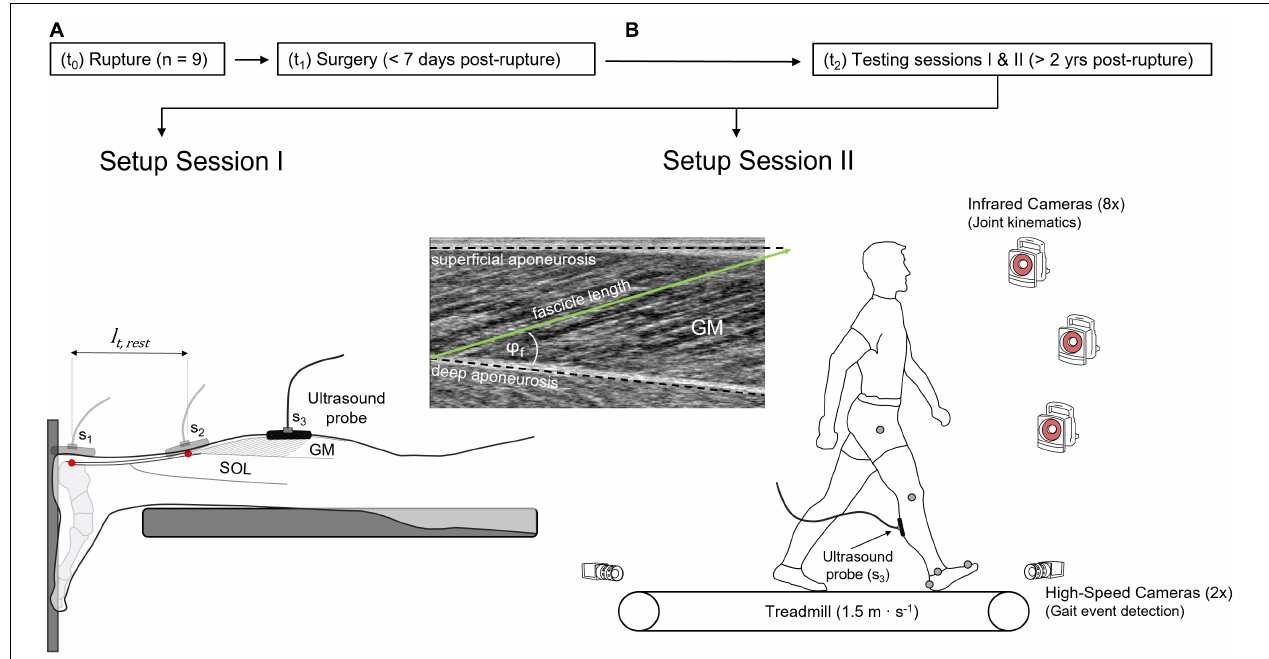
FIGURE 1 | Experimental design. (A) Setup to determine gastrocnemius medialis (GM) tendon length and muscle architecture, showing the scanning location S 1 and S 2 of the ultrasound probe, visualizing the calcaneal insertion and the myotendinous junction of the GM tendon (red dots), respectively, defining GM tendon resting length ( l t , rest ). Scanning location 3 (S 3 , GM mid-belly) visualizes GM muscle architecture in resting muscle (A) and during walking trials (B) , detailed by the ultrasound image. The treadmill setup (B) includes the motion capture system and the high-speed cameras. t 0 : time-point of rupture, t 1 : time-point of surgery, t 2 : time-point of measurements, ϕ f : pennation angle.